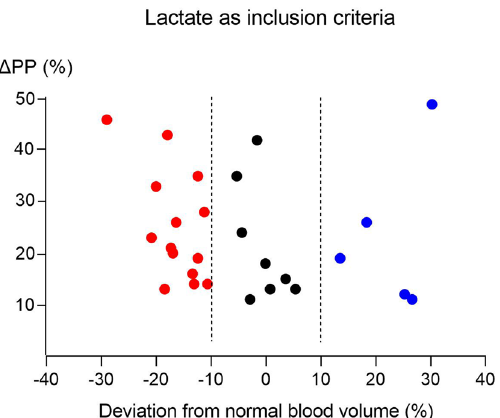
Fig. 5 Change in pulse pressure (ΔPP) following a passive leg raising test in relation to blood volume, in patients included due to lactate level > 2 mmol/l. No significant correlation could be found ( r 0.627–0.0871), p 0.11, Spearman correlation coefficient). Dotted lines illustrate limits of euvolemia [13] =